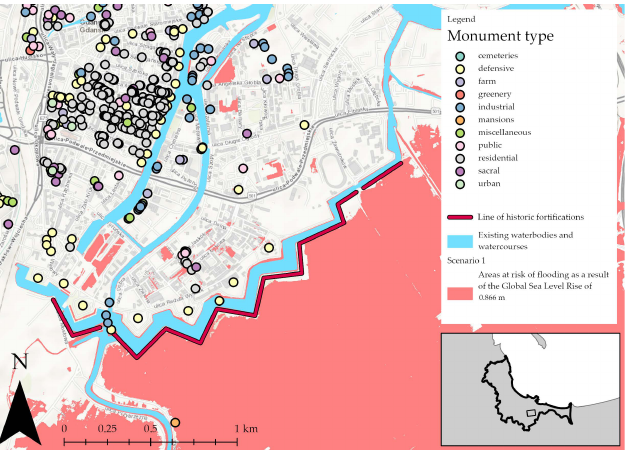
Figure 12. Close-up on Old Town in Gda´nsk, scenario 1—global sea level rise of 0.866 m. Source: own elaboration using ArcGIS Pro 2.7, on the basis of the data from Polish